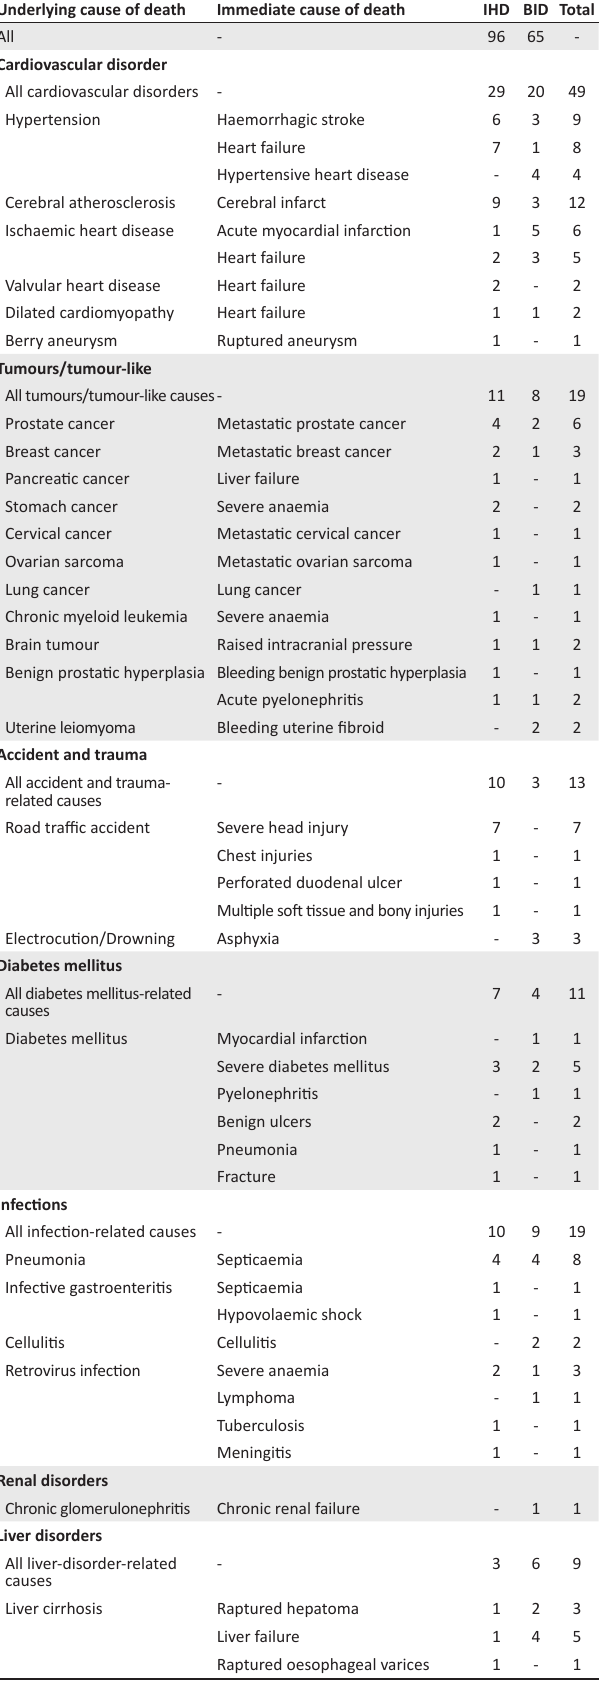
TABLE 4: Summary of non-SARS-CoV-2 related deaths at the 37 Military Hospital, Accra, Ghana, May 2020. Underlying cause of death